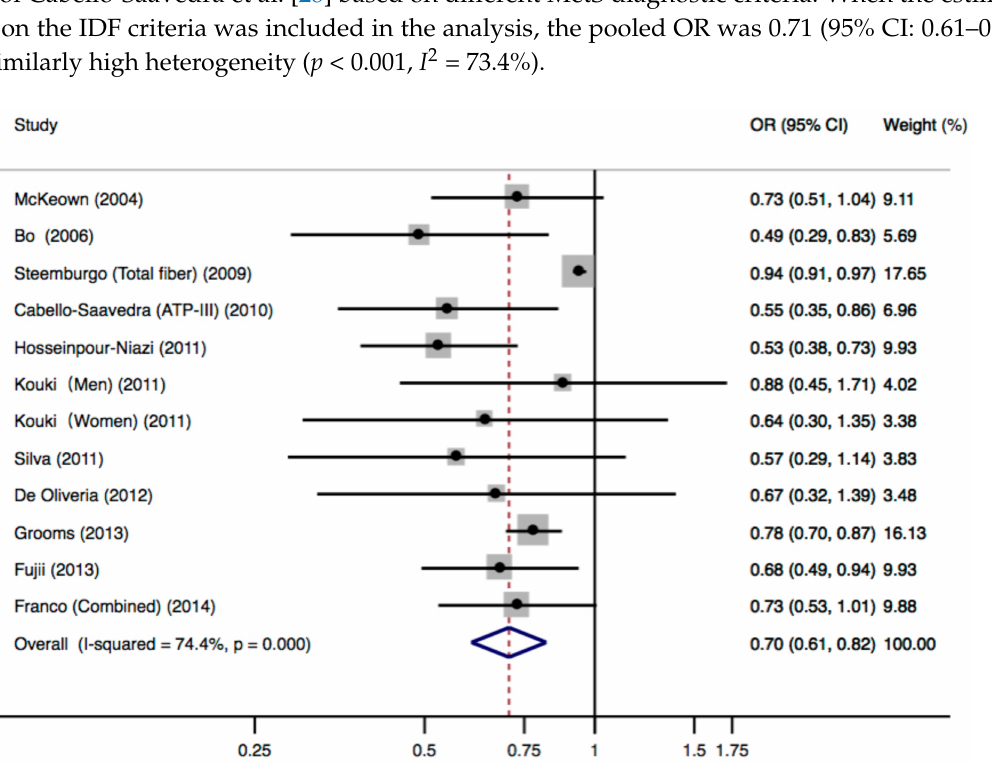
Figure 2. Meta-analysis of fiber intake (comparing the highest with the lowest fiber intake category) and risk of metabolic syndrome for 12 independent samples from 11 cross-sectional